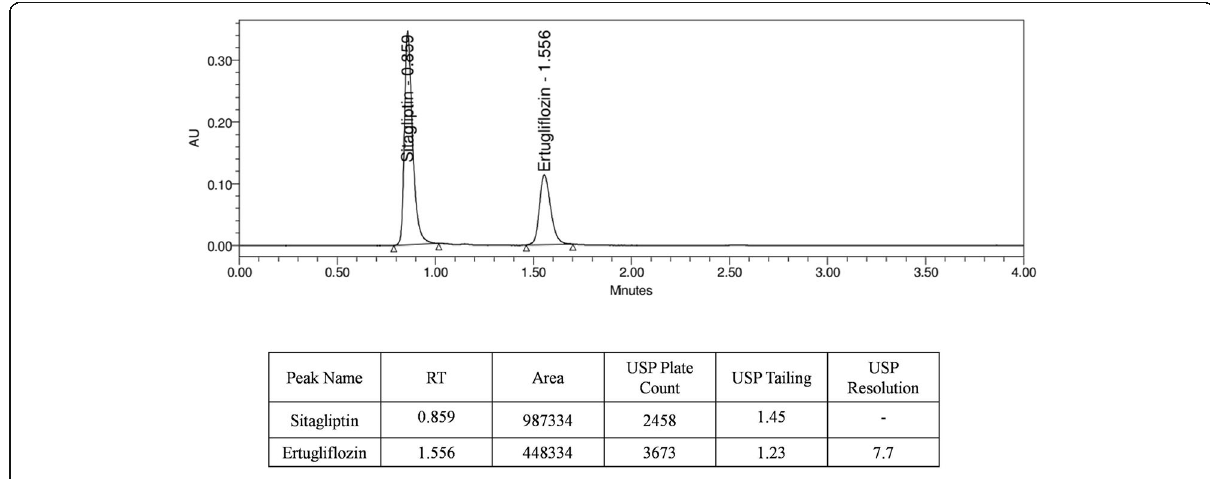
Fig. 3 Chromatogram of standard